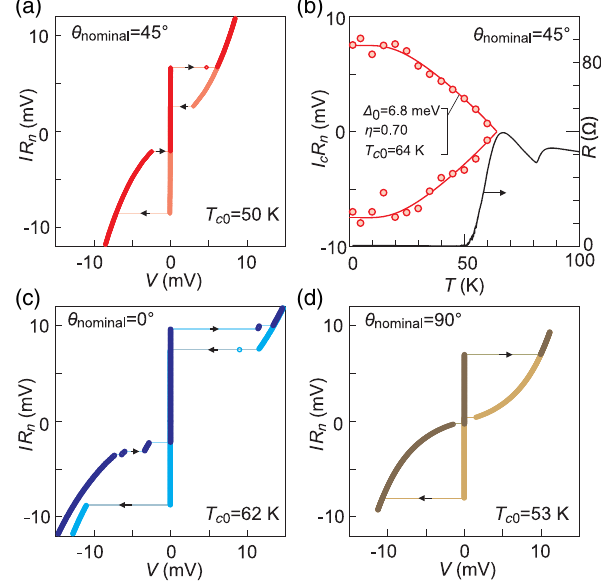
FIG. 6. (a),(c),(d) Normalized tunneling characteristics of BSCCO junctions at different twist angles (measured at 1.6 K). T c 0 represents the transition temperature of the junction region, as obtained from the temperature-dependent resistance measurement. (b) I c R n as a function of temperature for both the ¼ 45 °. positive and negative biases for the sample with θ nominal Red curves are fits to a modified Ambegaokar-Baratoff formula. Black curve is the temperature-dependent resistance measured across the junction. The temperature where I c R n drops to zero is slightly higher than T c 0 from resistance measurement, indicative of disconnected superconducting puddles at T > T c 0 FIG. 5. Josephson critical current as a function of the magnetic ¼ 45 ° (a),(b) and 90° (c), fields for three junctions with θ nominal respectively. B k indicates the field applied parallel to the BSCCO flakes. Solid curves are the Fraunhofer pattern. Insets show the false-colored scanning electron microscope images. Dotted lines demarcate the junction regions carved out by focused ion beam.